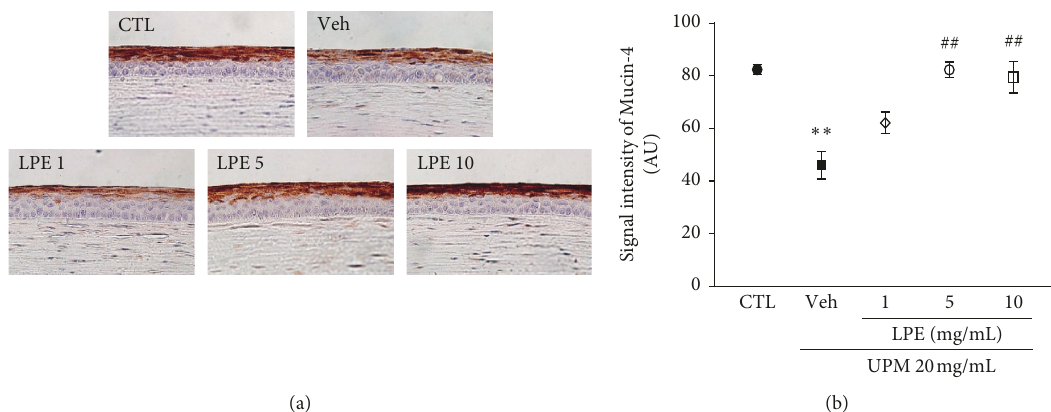
Figure 5: The effect of Liriope platyphylla extract (LPE) on a mucin protein (MUC4) in urban particulate matter (UPM)-induced dry eye syndrome (DES). (a) Representative images of MUC4-stained corneal sections of the Control (CTL), Vehicle (Veh), and LPE (1, 5, and, 10mg/mL) groups. (b) Graph of MUC4 signal intensity. Data shown are mean ± standard error. ∗∗ p < 0 . 01 vs. CTL; ## p < 0 . 01 vs. Veh.